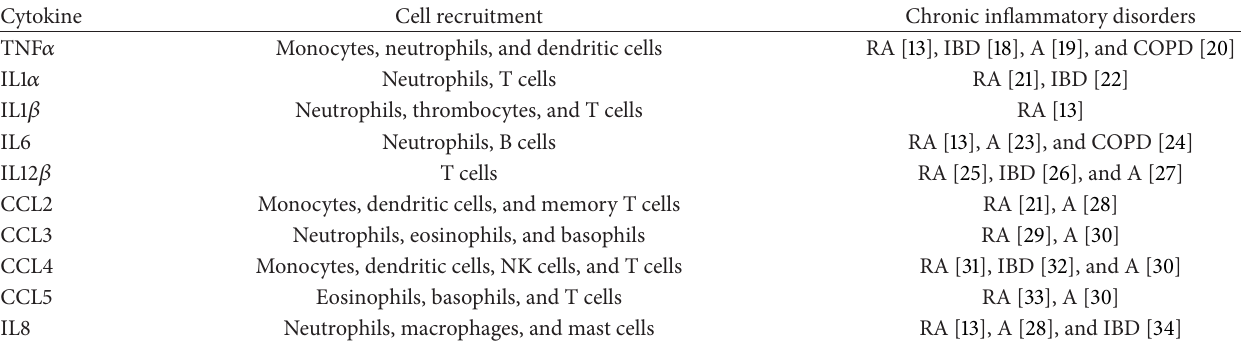
RA = rheumatoid arthritis, IBD = inflammatory bowel disease, A = atherosclerosis, and COPD = chronic obstructive pulmonary